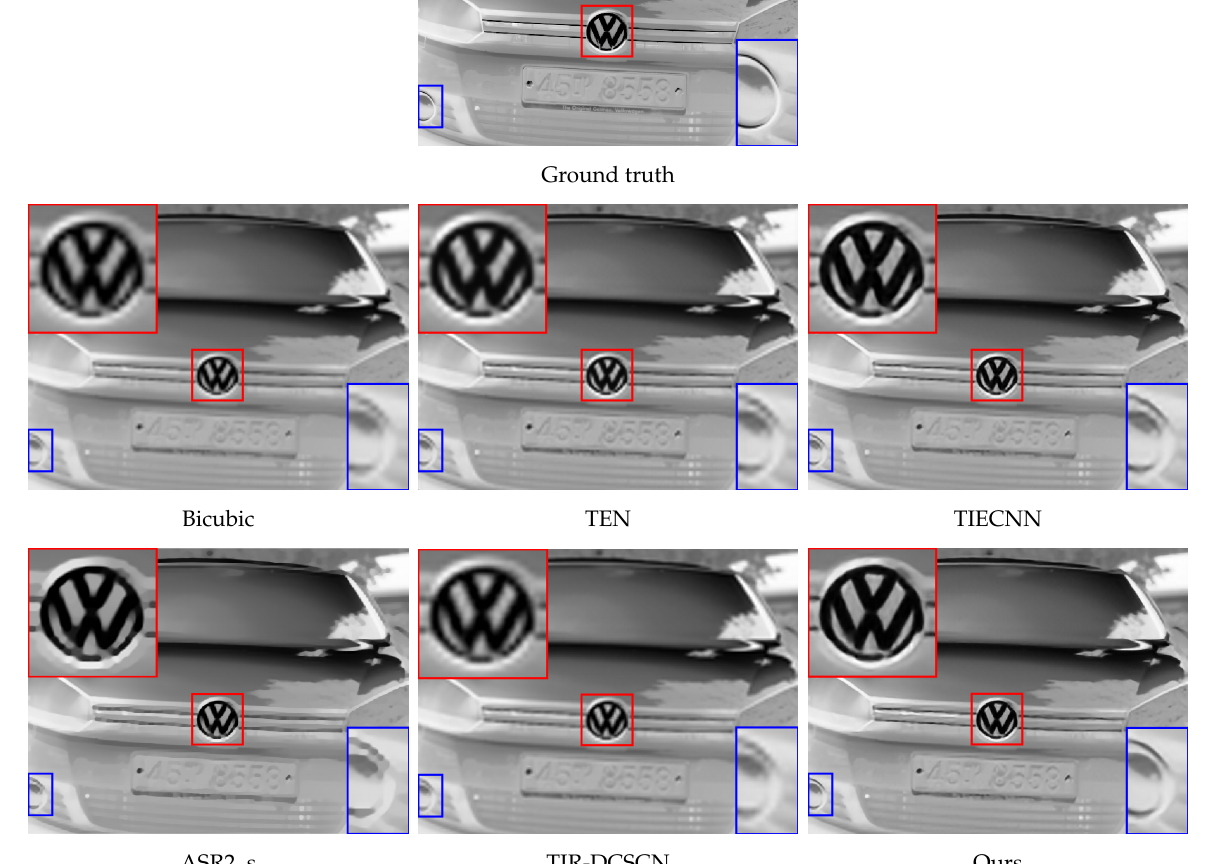
Figure 13. Qualitative comparison on the test dataset